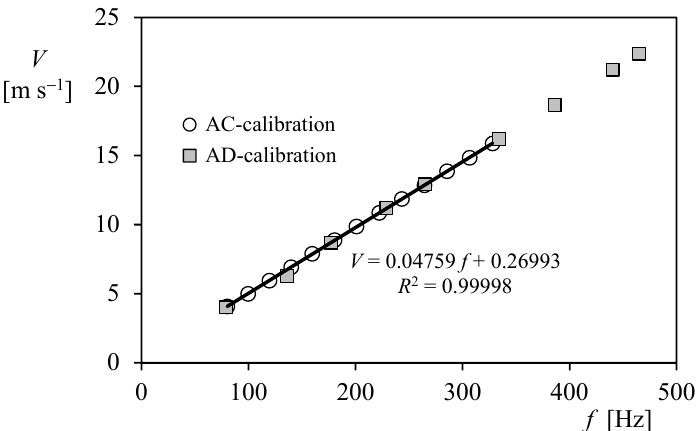
Figure 3. Two different calibrations performed on the same Thies Clima 4.3350 cup anemometer (see Figure 1): AC calibration (13 measurement points taken within a wind speed bracket from 4 m·s − 1 to 16 m·s − 1 ) and AD calibration (nine measurement points taken within a wind speed bracket from 4 m·s − 1 to 23 m·s − 1 ). The transfer function related to the AC calibration has been included in the graph. The coefficient of determination related to this linear fitting, R 2 , is also included in the graph (AC calibrations require high values of this coefficient).